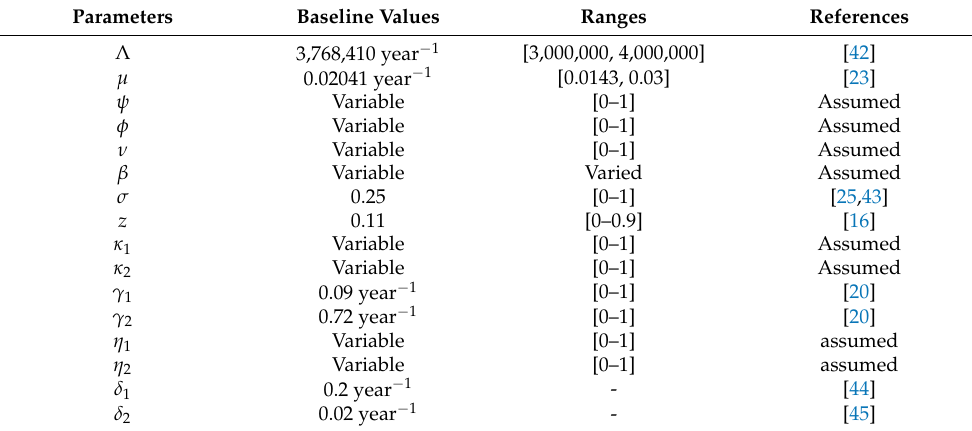
Figure 5. Impact of awareness rate ( ψ ) on S ι , E ι , I ι 1 ,and I ι 2 , varying ψ . Other parameters are given as Λ = 450,862, β = 0.86, ν = 0.25, φ = 0.2, σ = 0.65, z = 0.11, µ = 0.02041, ψ = 0.5, η 1 = 0.02, η 2 = 0.02, γ 1 = 0.5, γ 2 = 0.6, κ 1 = 0.03, κ 2 = 0.3, δ 1 = 0.2, δ 2 = 0.12. Table 3. The Parameters and Baseline Values of the Model with Public Health Education and Hospital Treatment